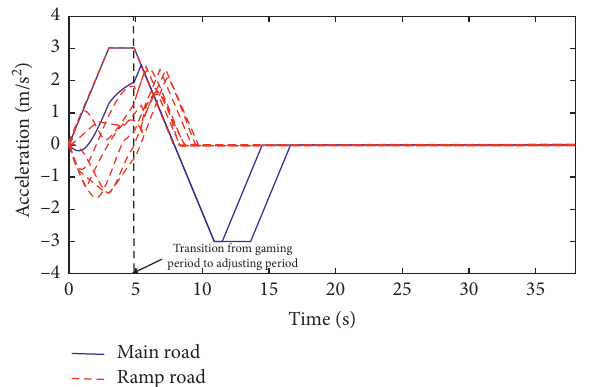
Figure 12: Acceleration of vehicles for Case Study